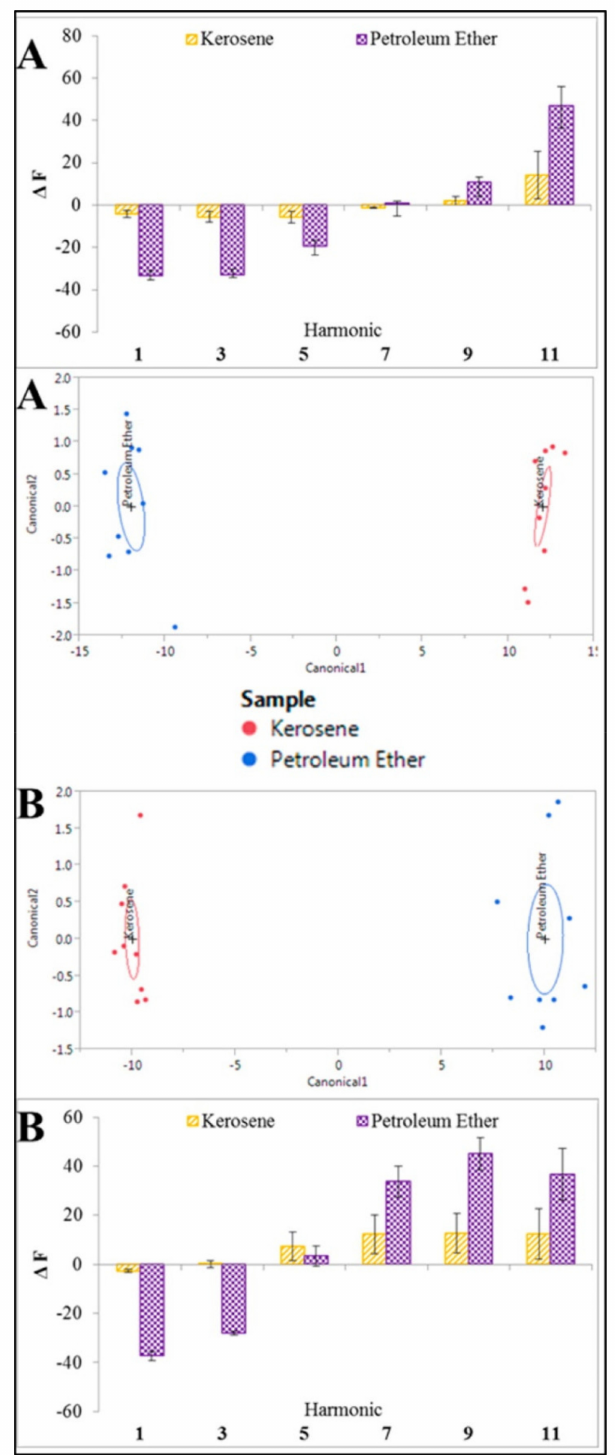
Figure 10. Frequency change at different harmonics and QDA, and canonical plots for petroleum ether and kerosene. ( A ) VSA coated with [OMIm][Br] and ( B ) VSA coated with [OMIm][SCN]. Figure is reproduced from